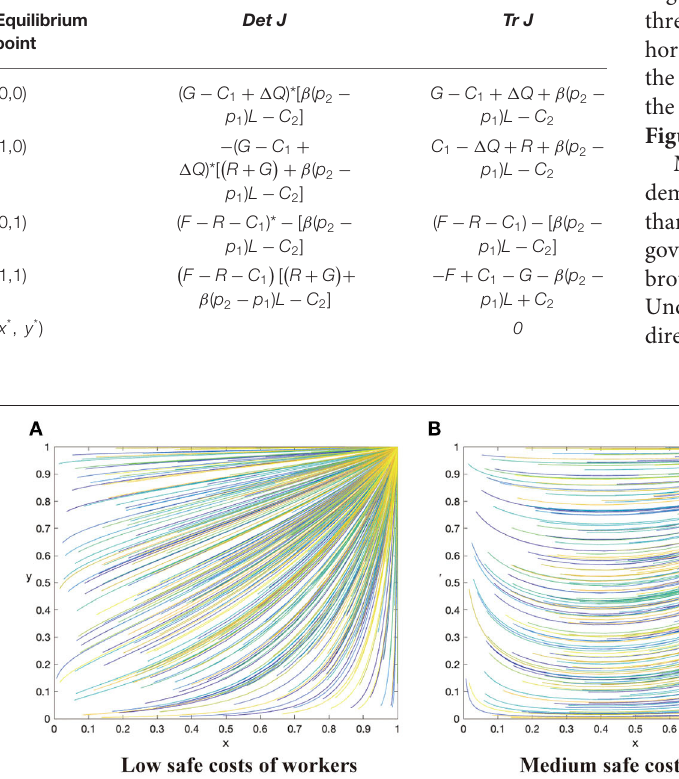
Frontiers in Psychology |